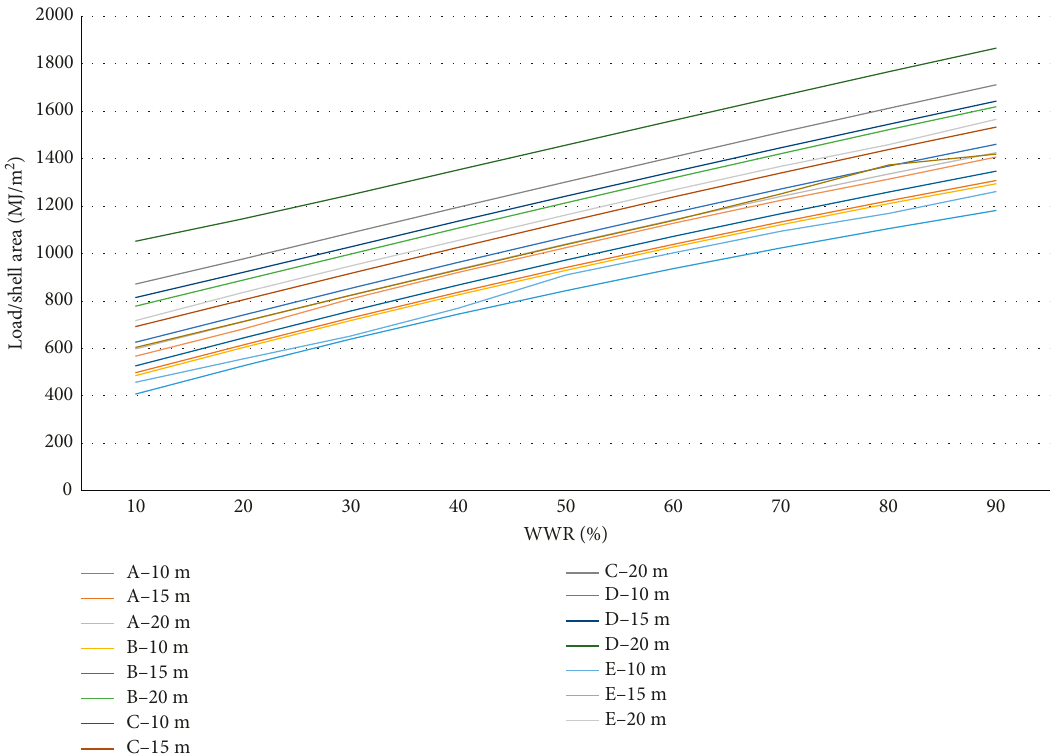
Figure 8: Energy consumption per shell area by tower type and scale (MJ/m 2 ): business